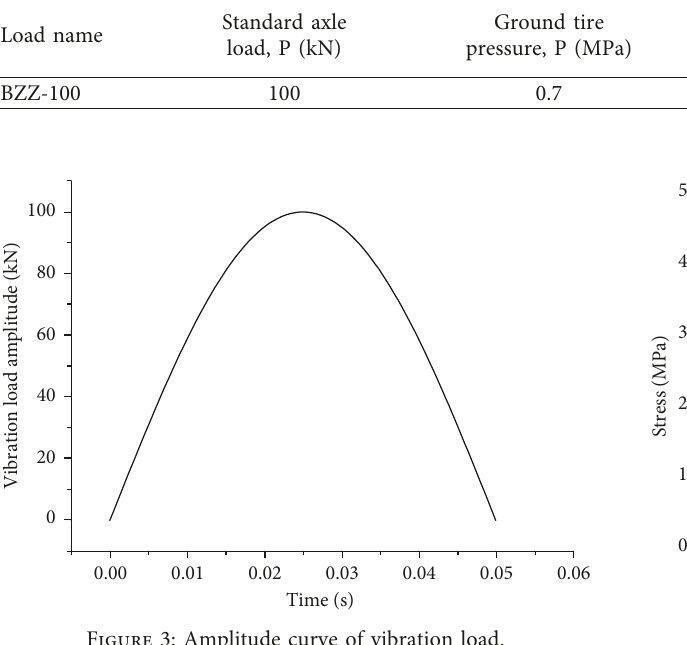
Figure 3: Amplitude curve of vibration load.